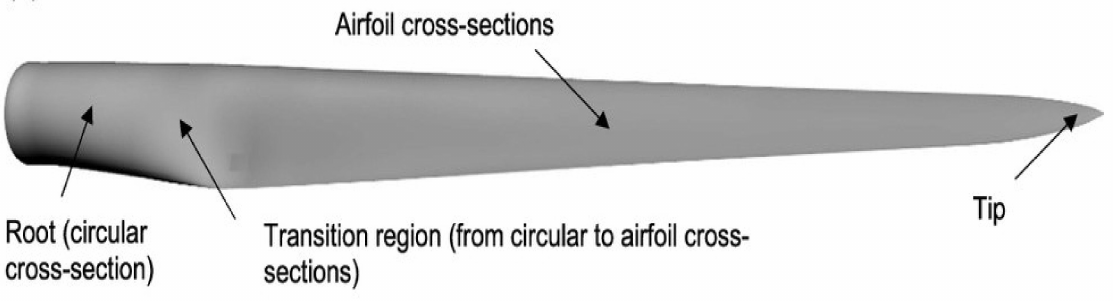
Figure 15. Wind turbine blades